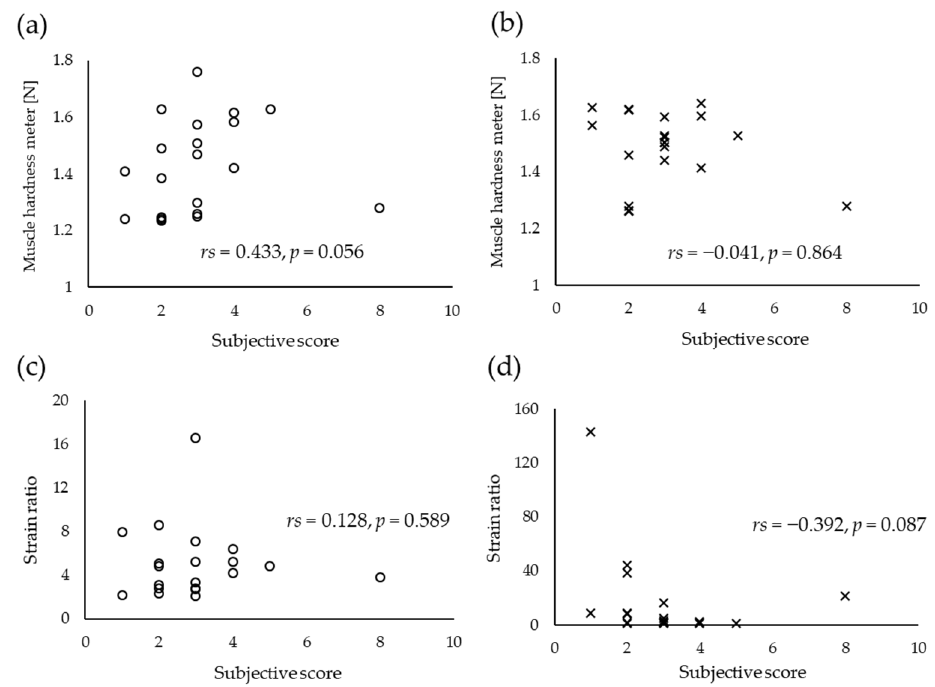
Figure 5. Relationship between subjective and objective shoulder stiffness ( n = 20). Muscle hardness meter for the ( a ) right and ( b ) left sides. Strain ratio for the ( c ) right and ( d ) left sides evaluated using strain elastography.